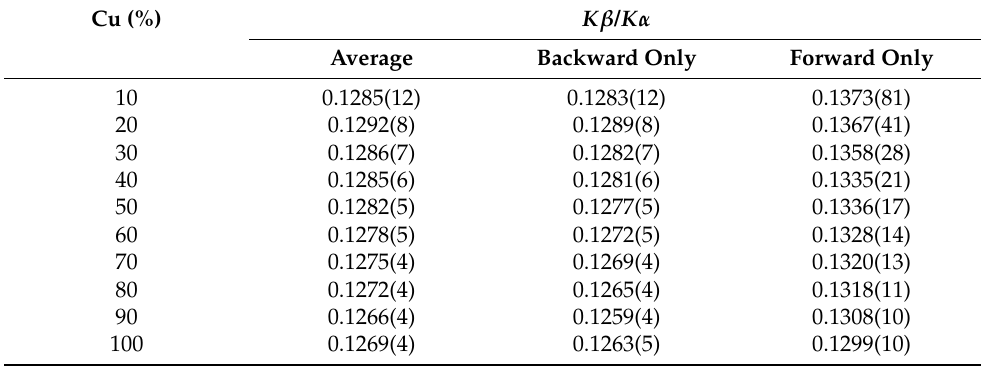
Table 1. Simulated K β / K α intensity ratio for 1 µm thick samples induced by Rh X-ray tube radiation, calculated for backward and forward direction and weighted average of them.